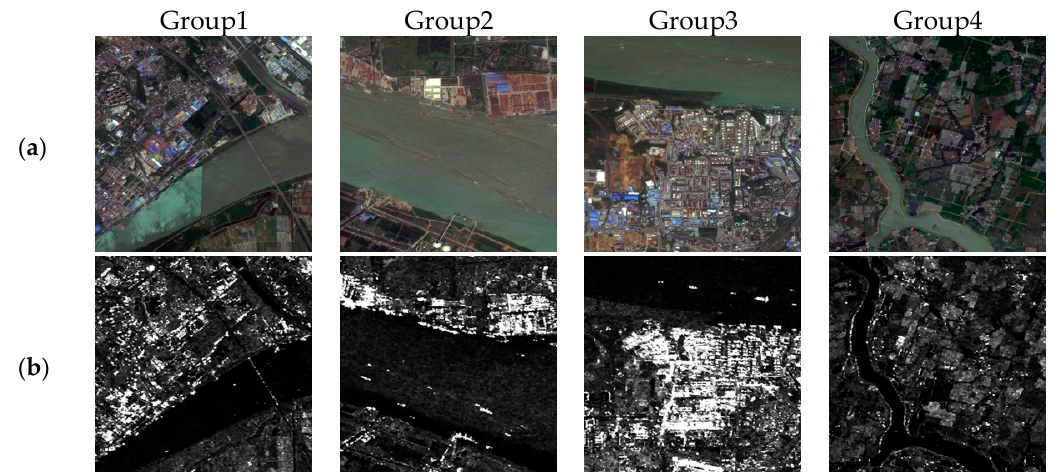
Figure 6. Four groups of original images. ( a ) Optical image; ( b ) SAR image